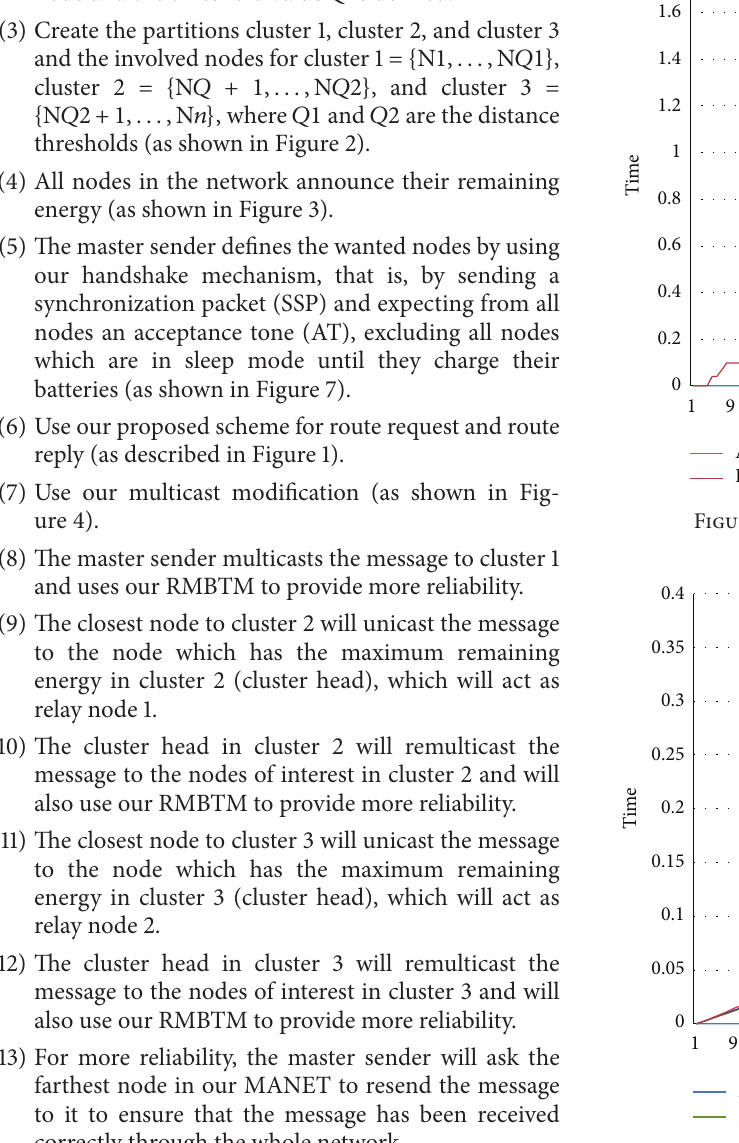
Figure 10: Comparison of delay